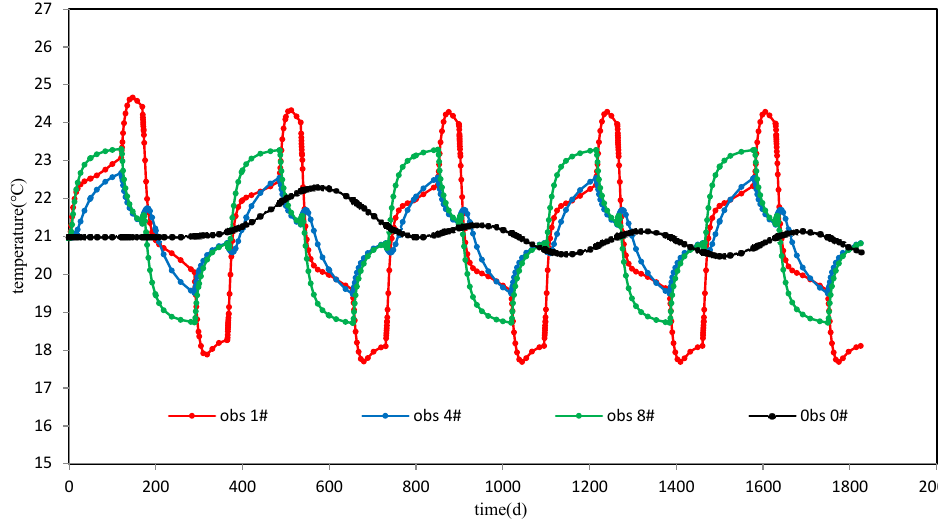
Figure 6. Temperature vs. time for observation wells (F1).